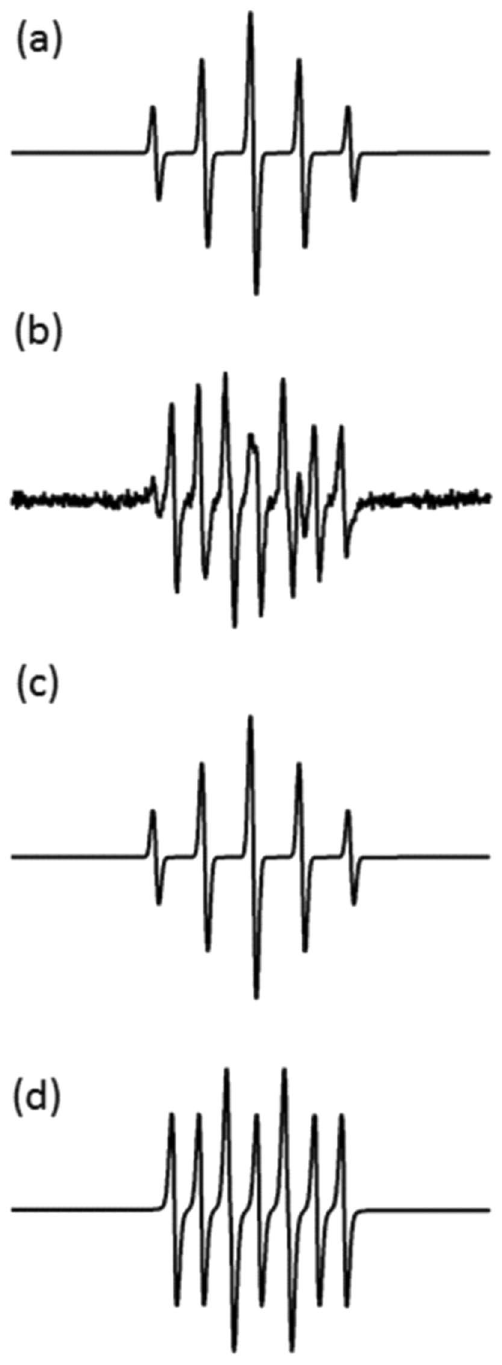
Figure 7. EPR spectra of C-PTIO in Milli-Q water with or without plasma treatment. ( a ) Experimental spectrum of 166 µ M C-PTIO in Milli-Q water. ( b ) Experimental spectrum of 16 6 µ M C-PTIO in Milli-Q water after 150 s of plasma treatment. Two components are identified in experimental spectrum ( b ) by computer simulation represented in ( c ) and ( d ). ( c ) EPR simulation of C-PTIO identical with spectrum ( a ). ( d ) EPR simulation of C-PTI resulting of the interaction between C-PTIO and nitric